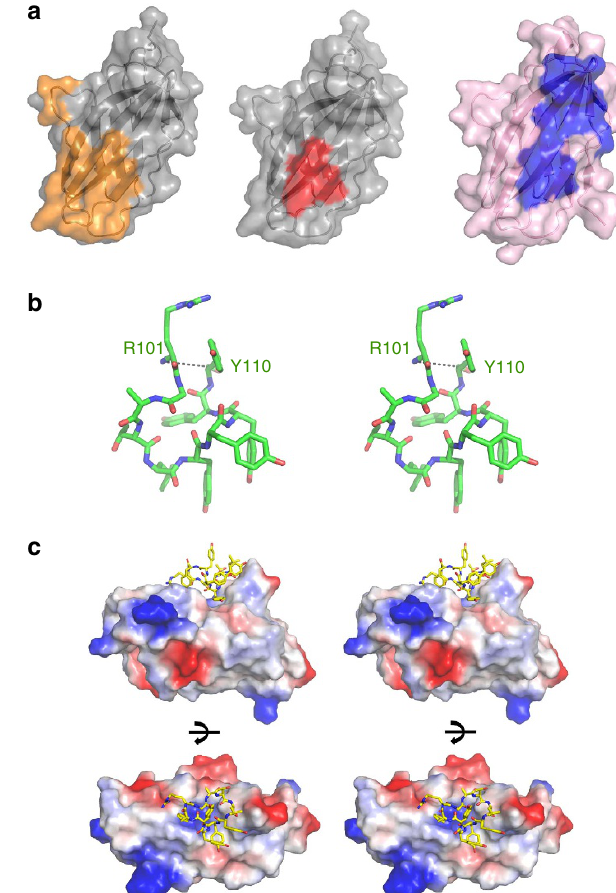
Figure 9 | Suggestion of a cyclic peptide as a modulator of the CTLA-4/B7 interaction. ( a ) Surface representations of the CTLA-4 molecule in the CTLA-4/B7-1 complex (left, PDB code 1i8l). The B7-1 binding site on the surface of CTLA-4 is coloured orange. Surface representations of CTLA-4 in the complex structures of CTLA-4/tremelimumab (right). The HCDR3 loop binding site on the surface of CTLA-4 is coloured blue. The overlapping region between the binding sites of B7-1 and HCDR3 is coloured red on the surface of CTLA-4 (centre). ( b ) Stereoview of the HCDR3 loop in the structure of CTLA-4/tremelimumab. The dashed line suggests a peptide bond between R101 and Y110 for generating a cyclic peptide. ( c ) Stereoview of a hypothetical model of the interaction between CTLA-4 (electrostatic surface representation) and the cyclic peptide based on the HCDR3 sequence of tremelimumab (yellow stick). The cyclic peptide was generated by connecting R101 and Y110 of the HCDR3 loop in the structure of CTLA-4/tremelimumab through a peptide bond, and its structure was polished by regularization and real space refinement in COOT (ref. 52). In this model, the cyclic peptide retains all of the interactions of HCDR3 in the structure of